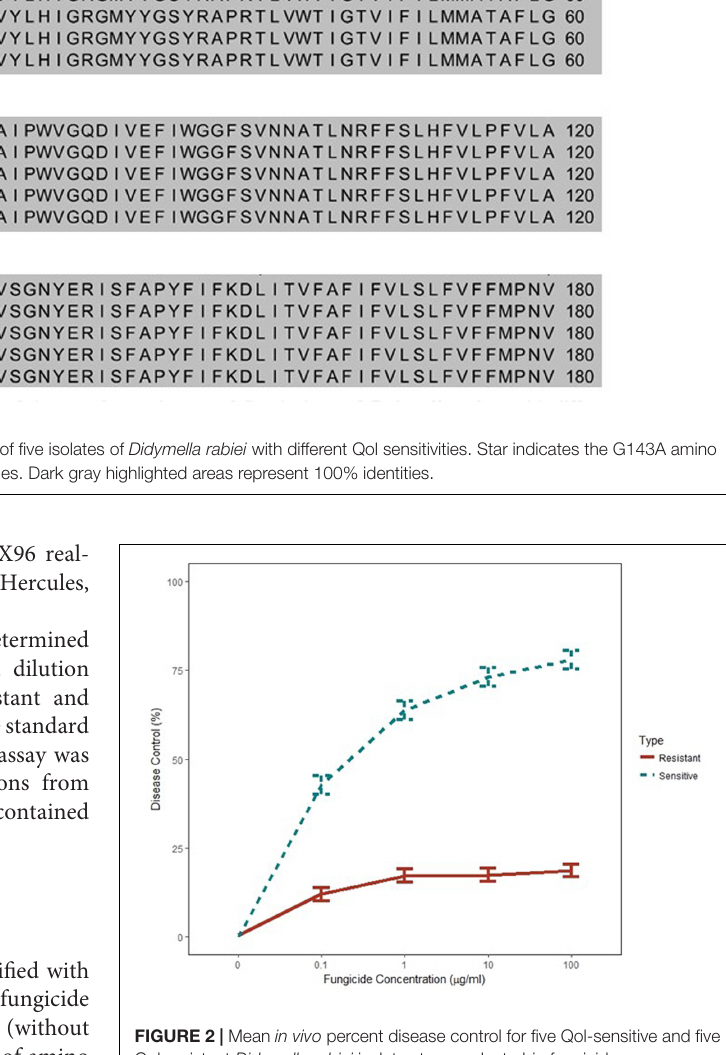
FIGURE 2 | Mean in vivo percent disease control for five Qol-sensitive and five Qol-resistant Didymella rabiei isolates to pyraclostrobin fungicide concentration ( µ g/ml). Values include standard errors of disease control measurements obtained from one plant across nine replications in two